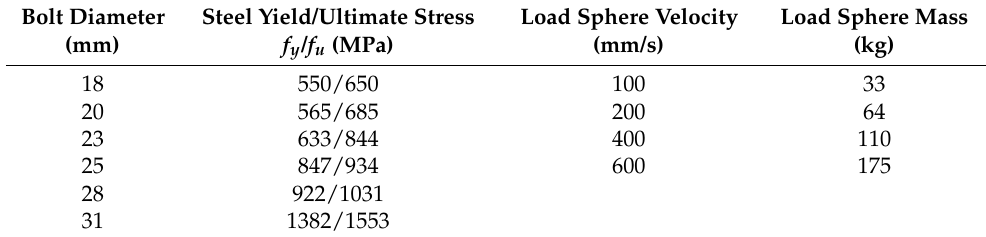
Table 13. Summary of tested variables.